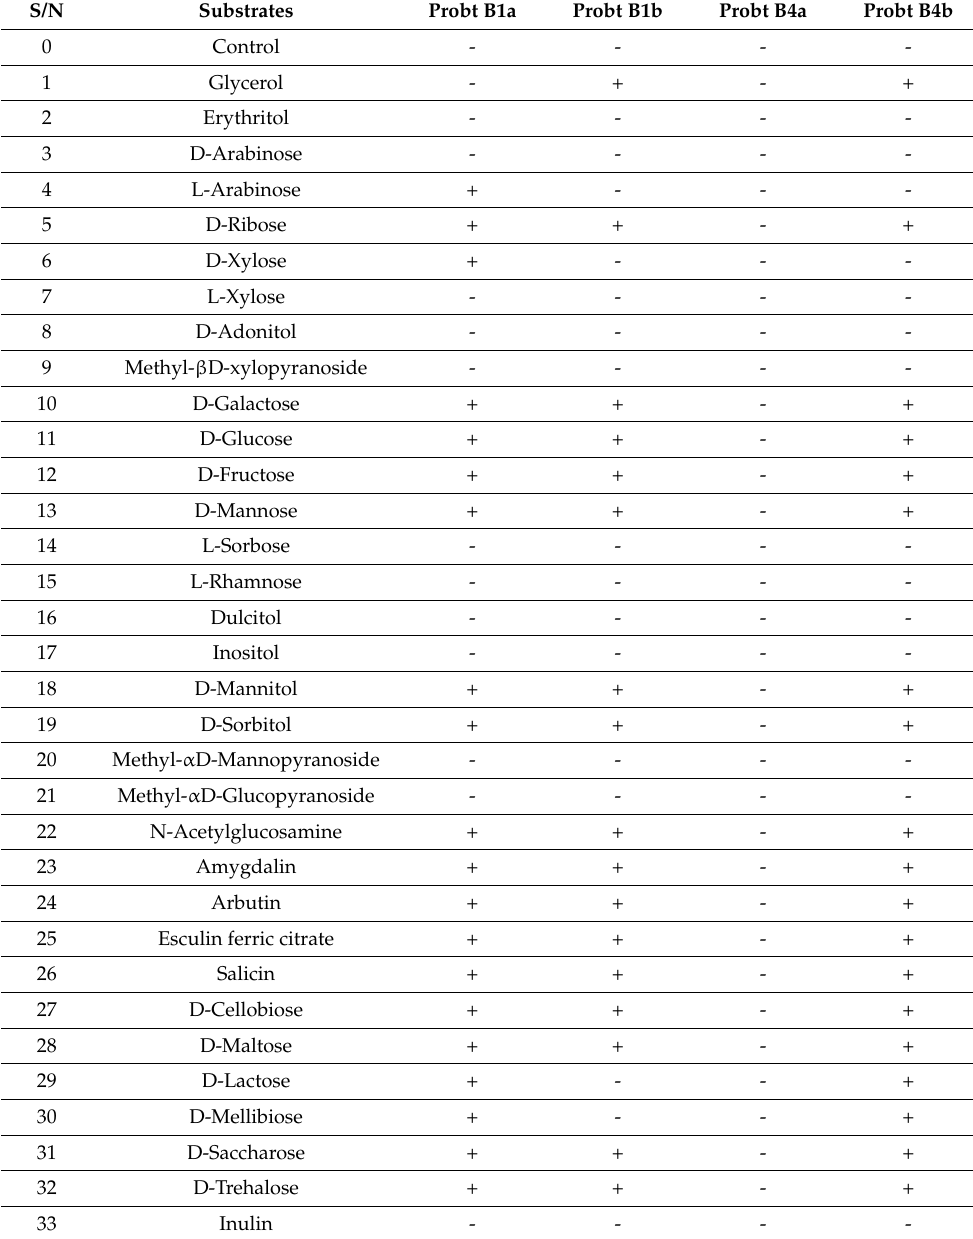
Table 5. The pattern of the sugar metabolism for the isolated lactic acid bacteria